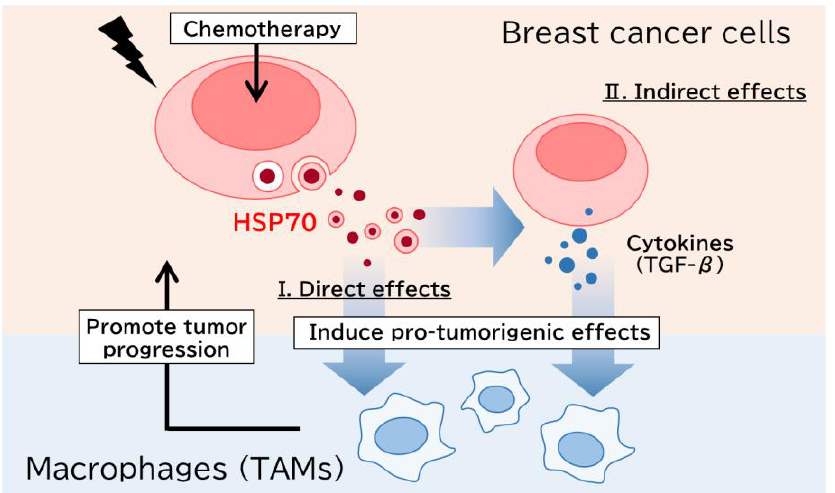
Figure 6. Representative image of the present study. Following chemotherapy, HSP70, which is partially contained in sEVs, is secreted from breast cancer cells. Extracellular HSP70 affects macrophages directly and regulates their polarization and pro-tumorigenic functions, while it also alters TGF-β expression in breast cancer cells and educated macrophages to promote breast cancer progression.